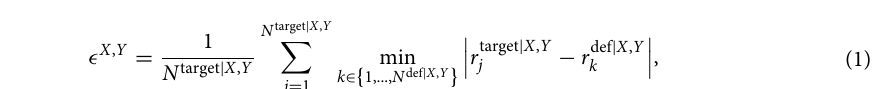
Figure 2. Schematic representation of a difference operator quantifying multiple feature changes. (cid:31) def and (cid:31) target have five node sets contained in list N : three represent material regions ( A , B , and C ), and the other two include the inner and outer surfaces ( J and O ). Corresponding interfaces on the deformed (solid) and target (dashed) geometries were compared by calculating the average Euclidean distance between their nodes (black arrows), based on a nearest neighbor